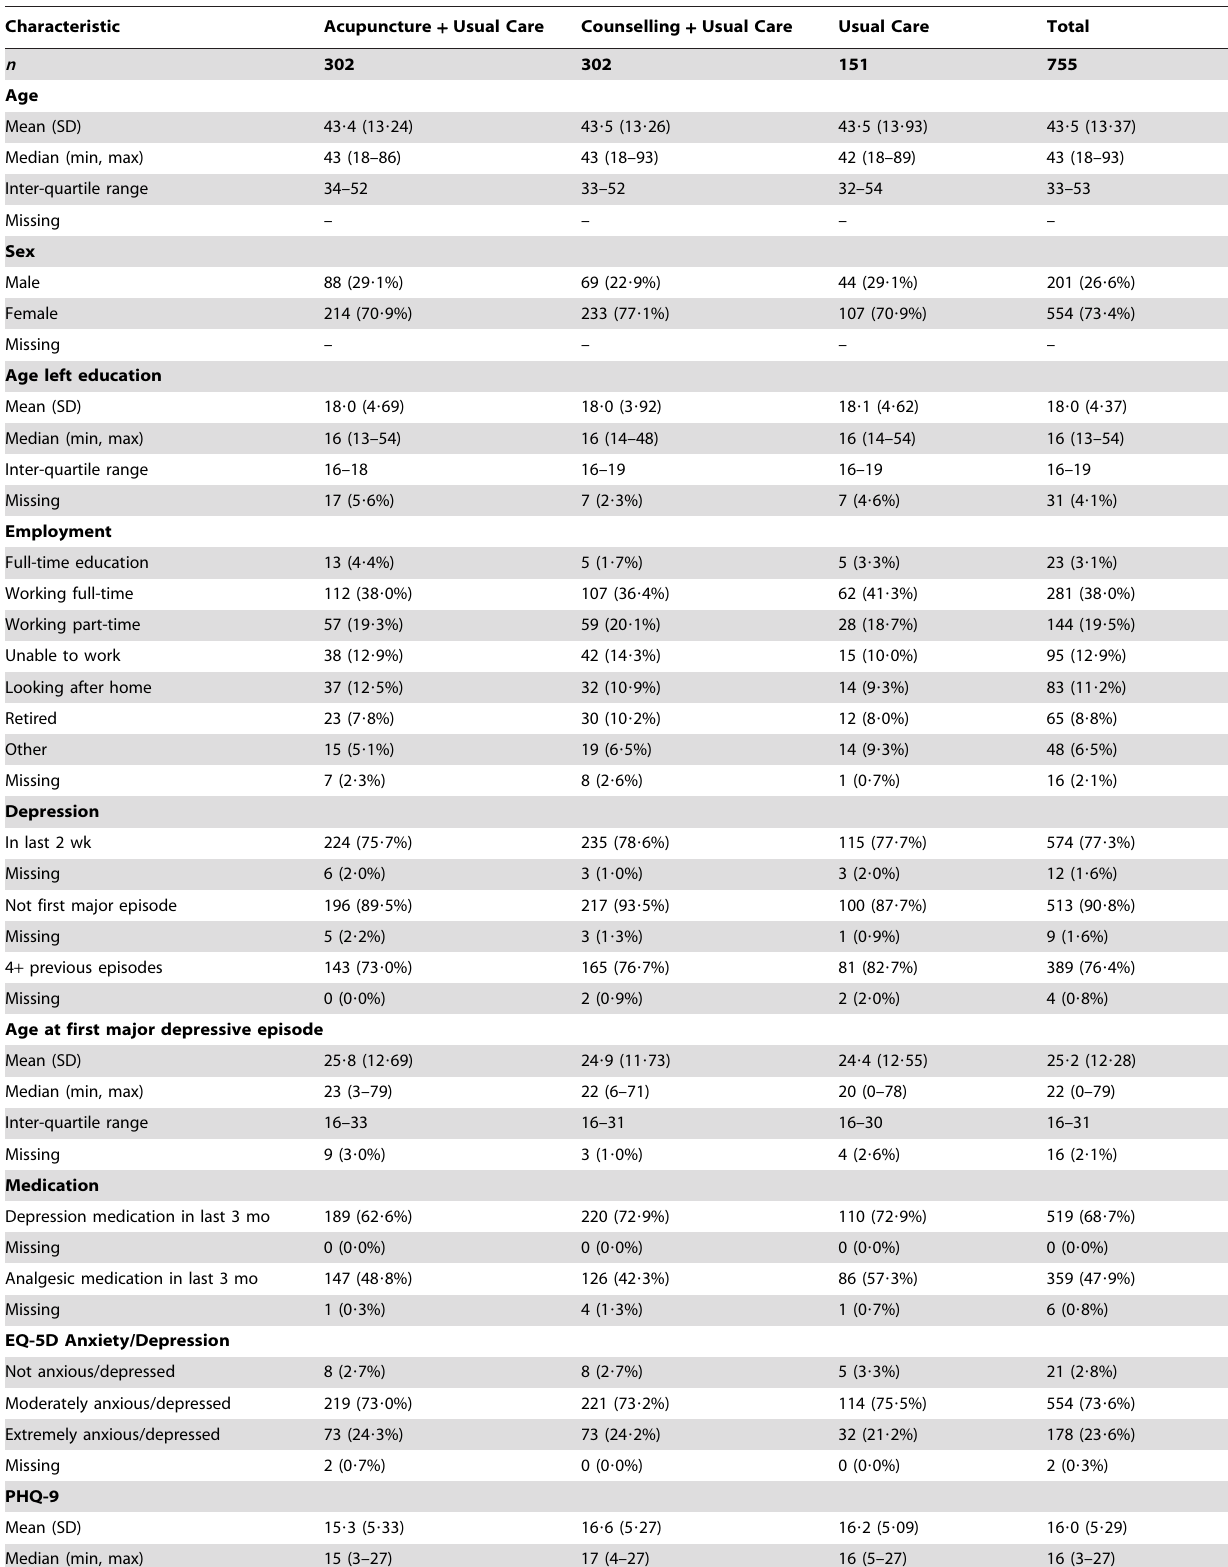
Table 1. Demographics and variables of interest at